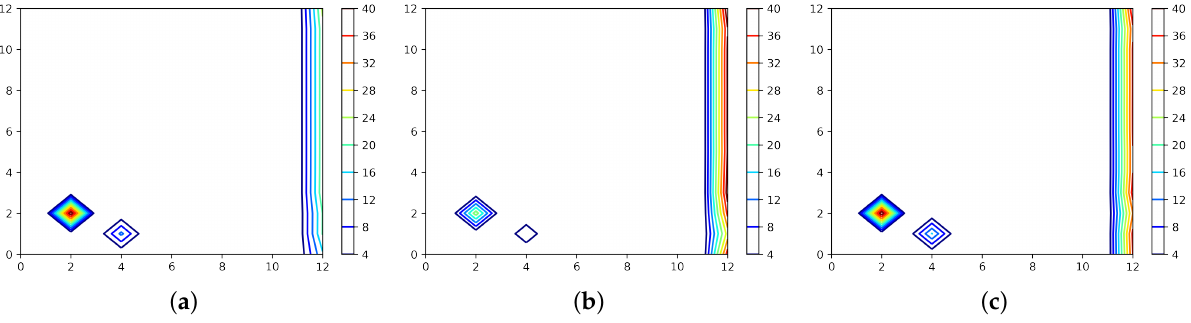
Figure 9. Feature spectrum in channel 4: ( a ) 4 µ g/L testing phenol; ( b ) testing drinking water; ( c ) 4 µ g/L training phenol.